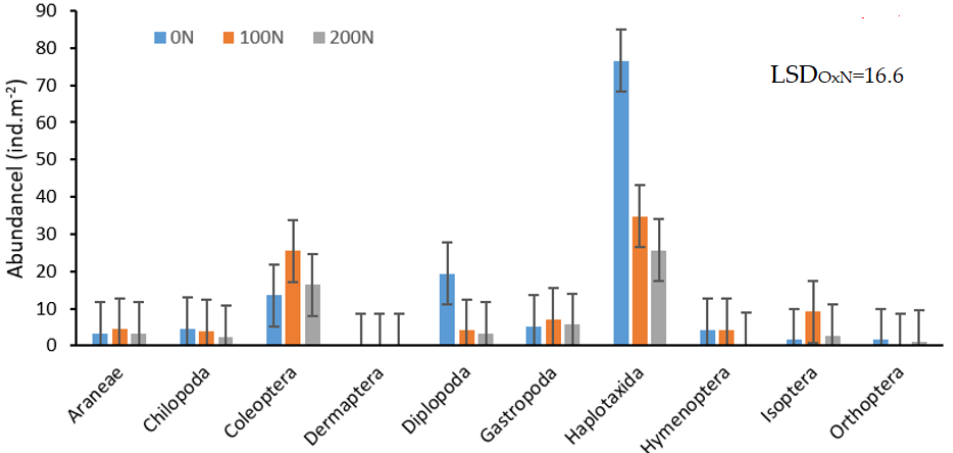
Figure 6. Variation in abundance of the different taxonomic groups in three treatments of N fertiliser application rate (0, 100 and 200 kg/ha) after 17 years of trial establishment. O = orders and N = nitrogen fertiliser application rate.